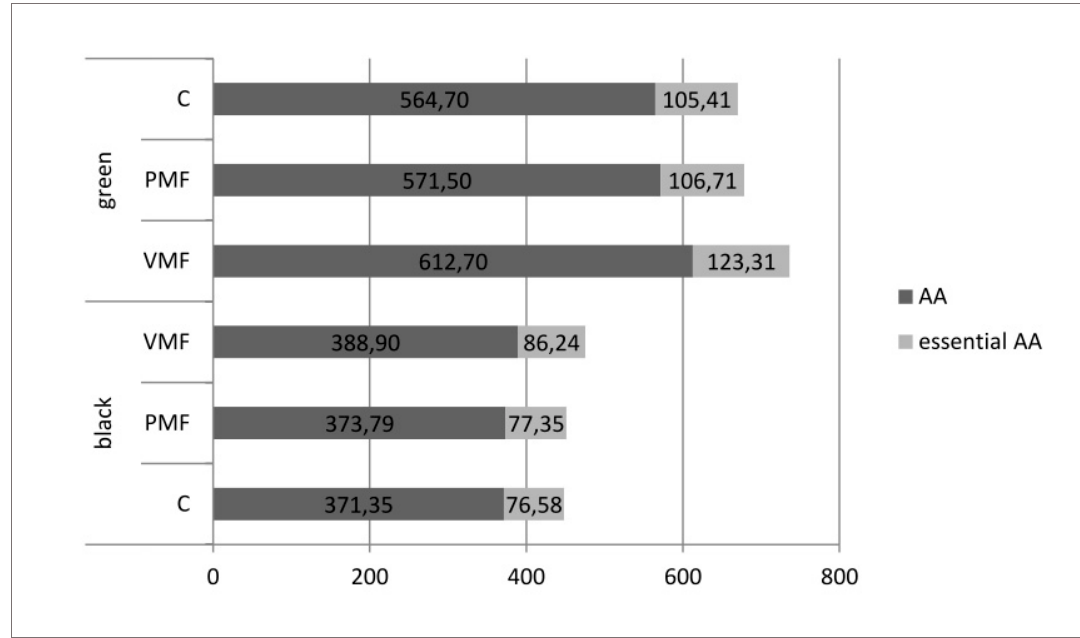
Figure 3. Total content of amino acids (AAs) and essential amino acids (essential AAs) in the tea infusion samples (mg L − 1 ).